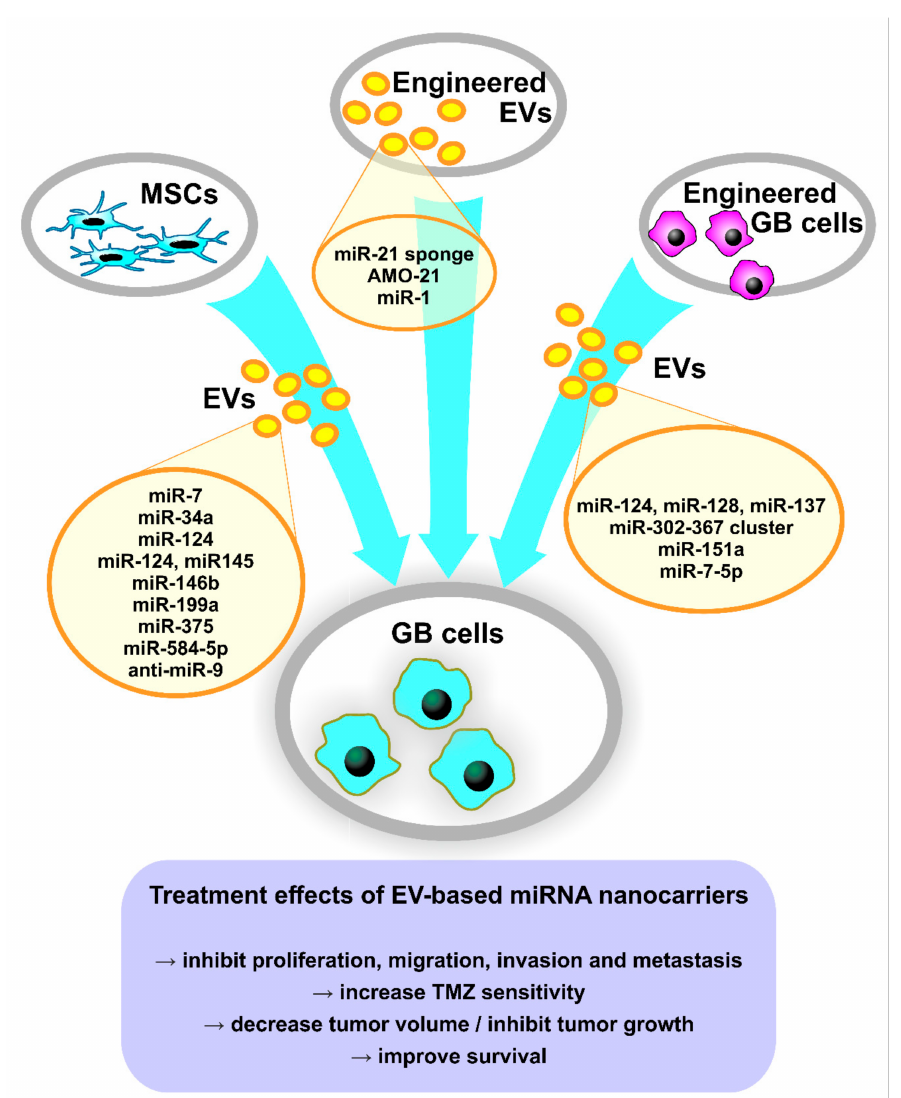
Figure 2. Tailoring approaches of EVs’ miRNA cargo for GB therapy. AMO-21, anti-miR-21 oligonu- cleotides; EVs, extracellular vesicles; GB, glioblastoma; miRNA, microRNA; MSCs, mesenchymal stem cells; TMZ,